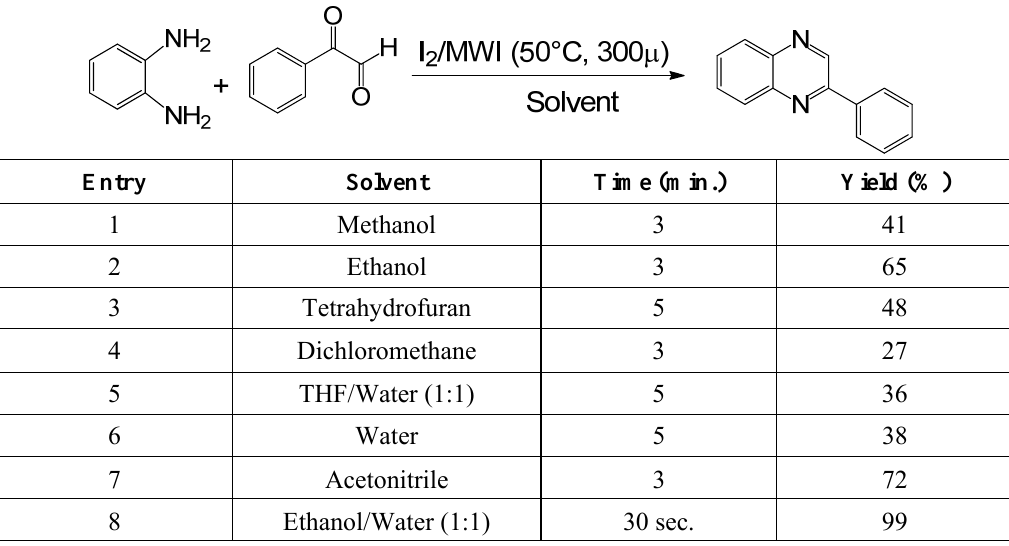
Table 1. Reaction between o -phenylene diamine and phenylglyoxal monohydrate in the presence of iodine (5 mol %) in different solvents under microwave